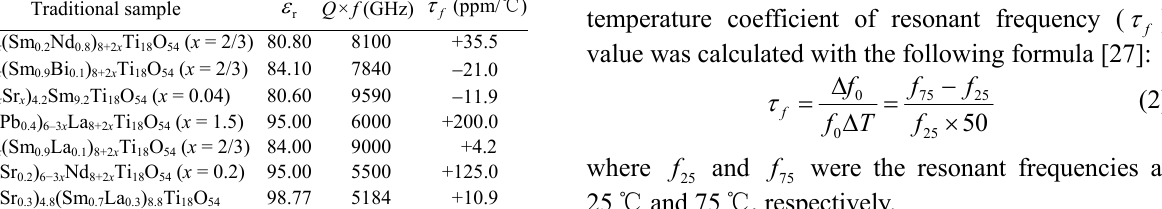
Table 1 Dielectric properties of Ba 6–3 x Ln 8+2 x Ti 18 O 54 ceramics Traditional